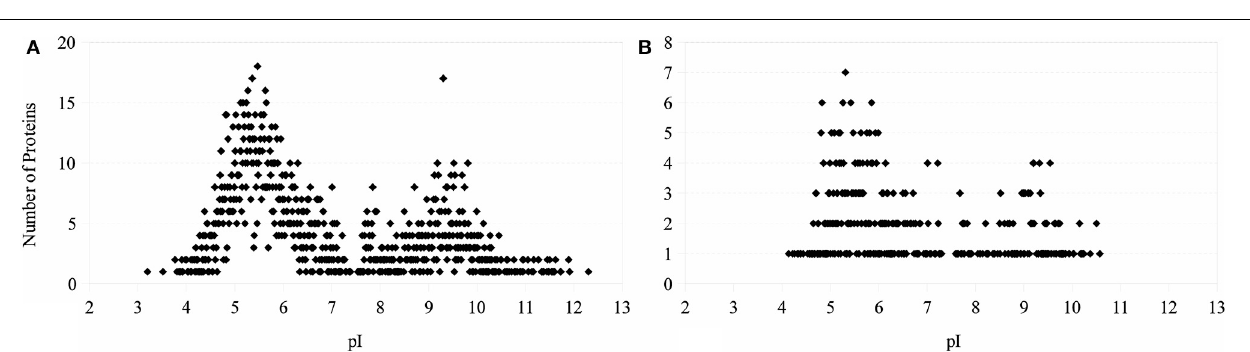
FIGURE 6 | Left: Number of assigned spectra as a function of isoelectric point of the identified protein (A: osmotic-shock sample; B: crude extract). Right: Number of proteins identified as a function of their isoelectric point ( C : osmotic-shock sample; D : crude extract).